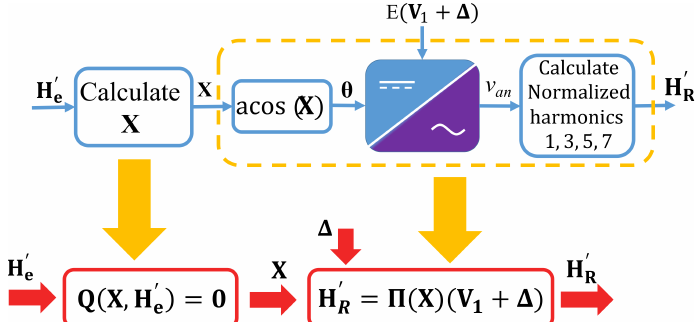
Figure 6. static model and block diagram of the system.